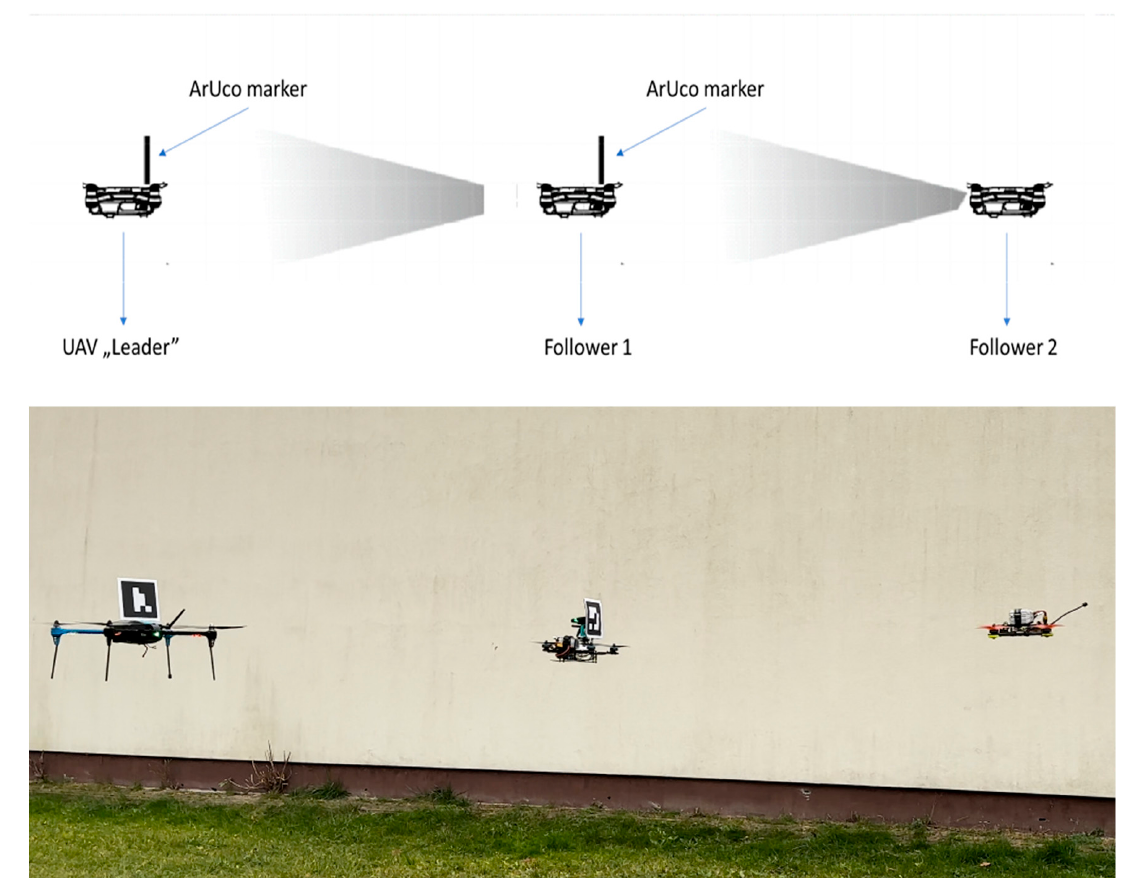
Figure 1. Assumptions of the designed system.